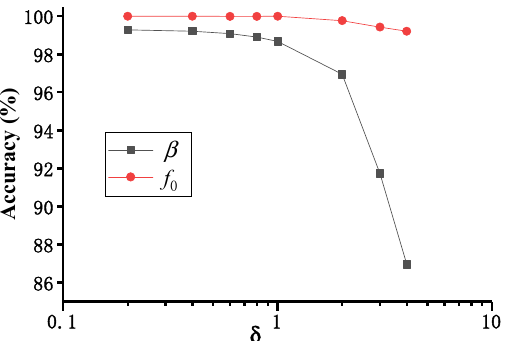
Figure 7. Calculation accuracy of decay rate β and resonant frequency f 0